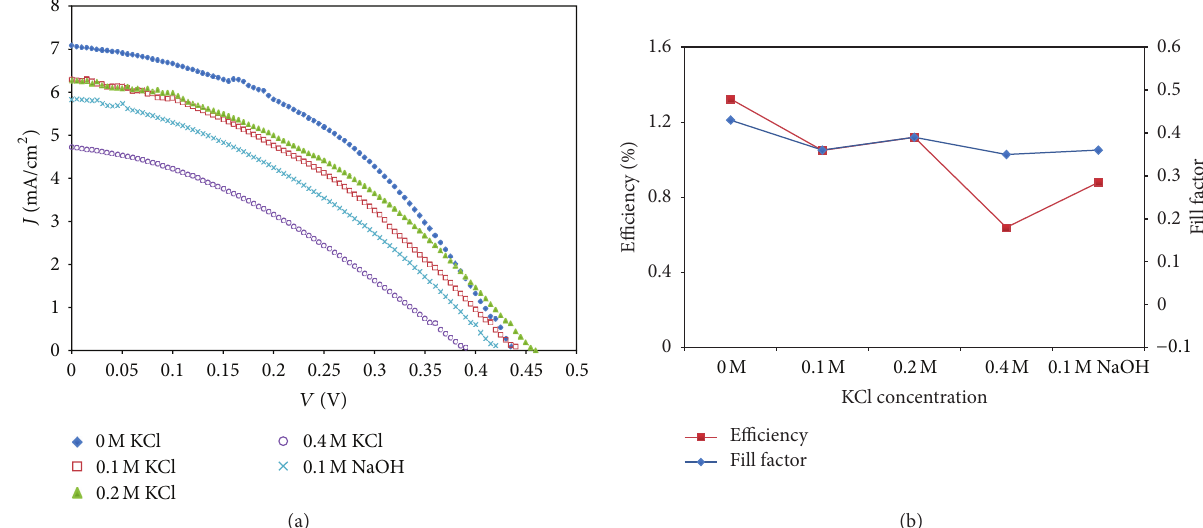
Figure 4: (a) 𝐽 - 𝑉 curves of CdSe QDSSCs with electrolytes having various amounts of KCl addtive. (b) Variation of efficiency and fill factor of the cells with the amount of KCl in the electrolyte. Electrolyte used: 0.5 M Na 2 S, 0.1M S in ethanol/water (8:2 by volume). Table 3: Performance parameters of CdSe QDSSCs with electrolytes having various amounts of S. The electrolyte used: 0.5M Na ethanol/water (8:2 by